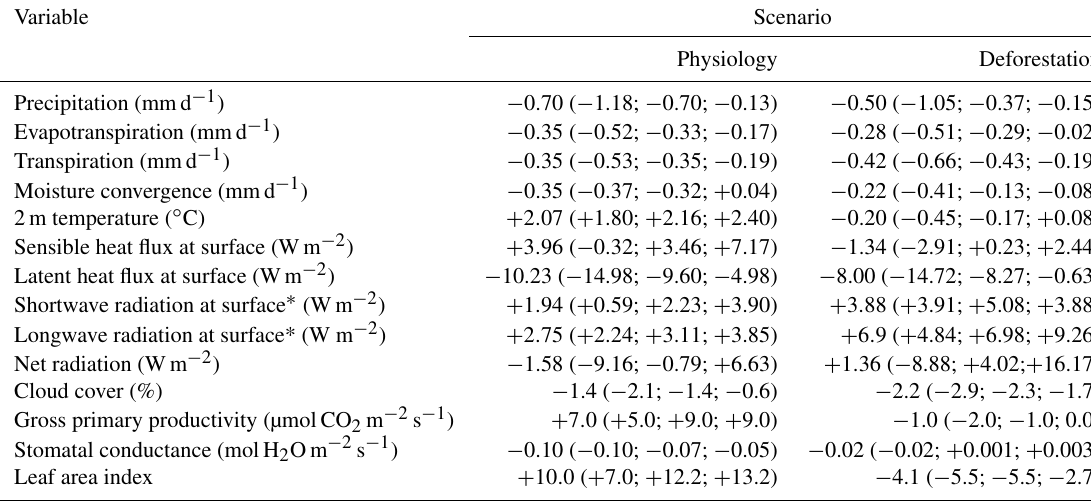
Figure 3. Mean annual changes in (a) the moisture budget, (b) the 2m air temperature and (c) the energy balance from the CPTEC-BAM over the Amazon region (black line square area in Fig. 5) under an atmospheric concentration of + 200ppmv (1.5 × CO 2 ) affecting solely surface vegetation physiology (Physiology) and with the complete substitution of the Amazon forest by pasture grasslands (Deforestation). Solid lines indicate the interquartile range (25th, 50th and 75th percentile values) obtained based on the spatial variability of the grid points used to determine the regional average. Table 2. Mean annual changes and interquartile ranges (25th, 50th and 75th percentile values in parentheses) of the moisture budget, 2m air temperature, energy balance, GPP, g s and LAI from the CPTEC-BAM over the Amazon region (black line square area in Fig. 5) under an atmospheric concentration of + 200ppmv (1.5 × CO 2 ) affecting solely surface vegetation physiology (Physiology) and with the complete substitution of the Amazon forest by pasture grasslands